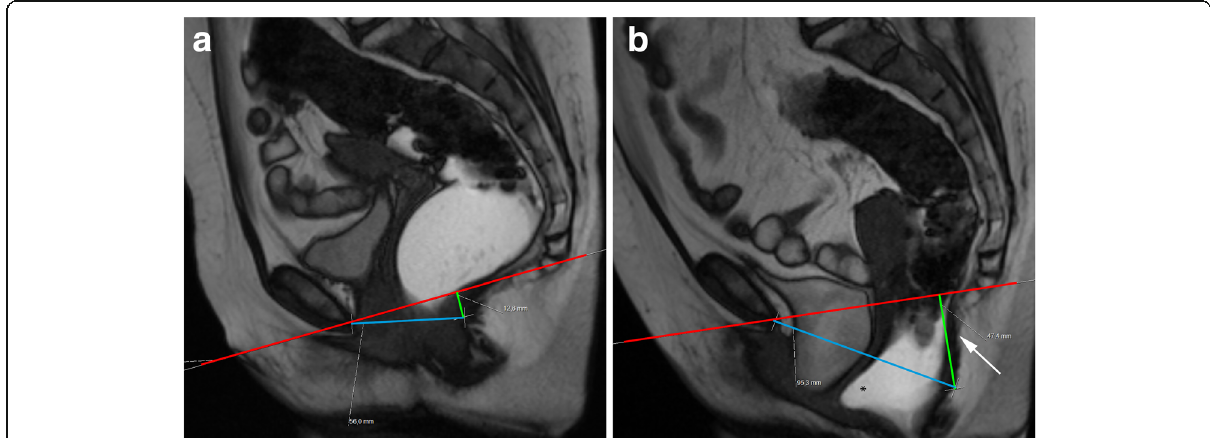
Fig. 17 Descending perineal syndrome with tricompartimental prolapse and anterior rectocele. ( a , b ) Sagittal midline TrueFISP images at rest ( a ) and during evacuation ( b ). H line (blue line) measures 5.6 cm ( a ) and 9.5 cm ( b ) and the M line (green line) measures 1.3 cm (a) and 4.7 cm (b) , demonstrating widening and descent of the levator hiatus. Note the vertical orientation of the levator plate (white arrow). It is also associated with a tricompartimental prolapse and an anterior rectocele (*)